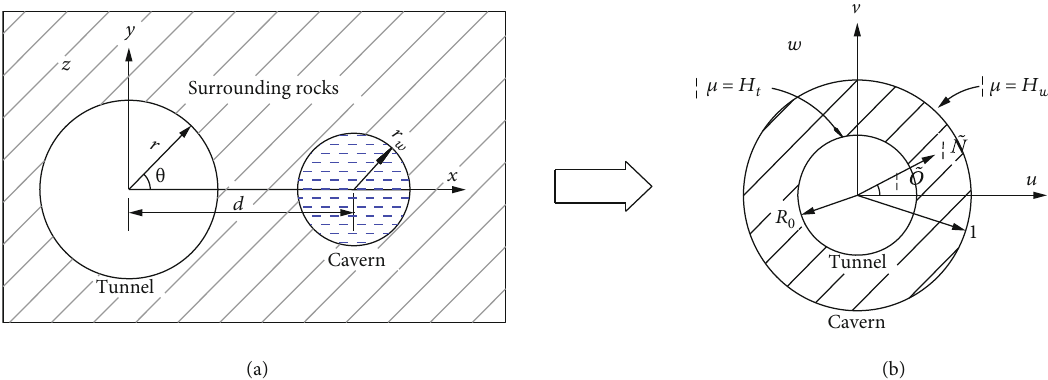
Figure 1: Theoretical model of the unsupported tunnel. (a) The tunnel and the cavern in the in fi nite aquifer. (b) Plane of conformal